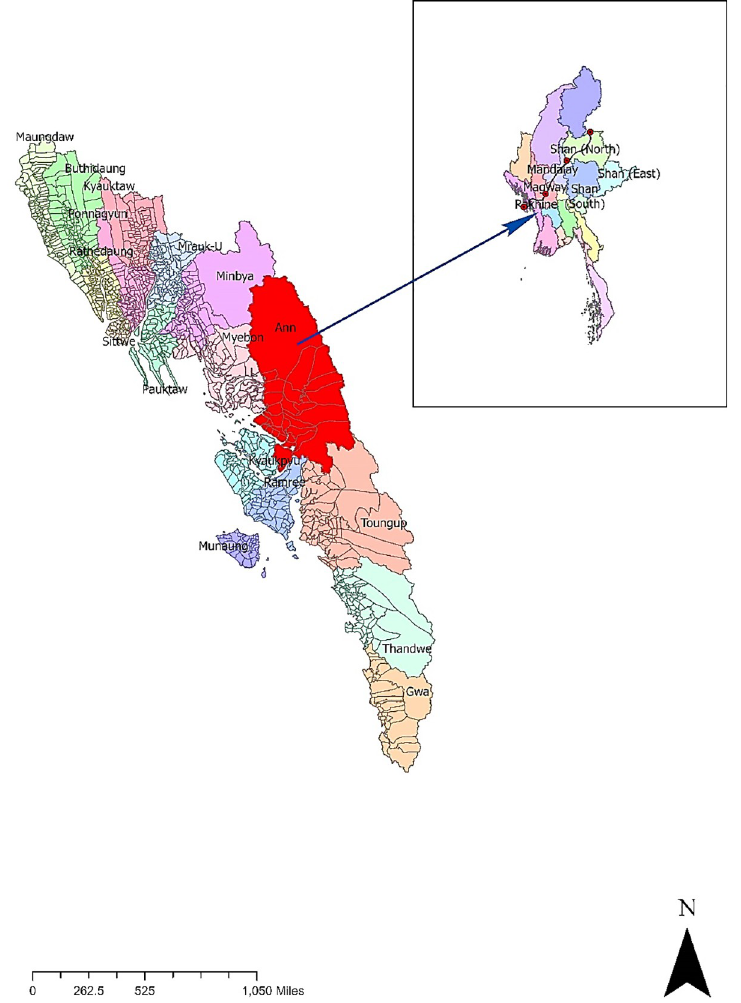
Fig 1. Location map of the study